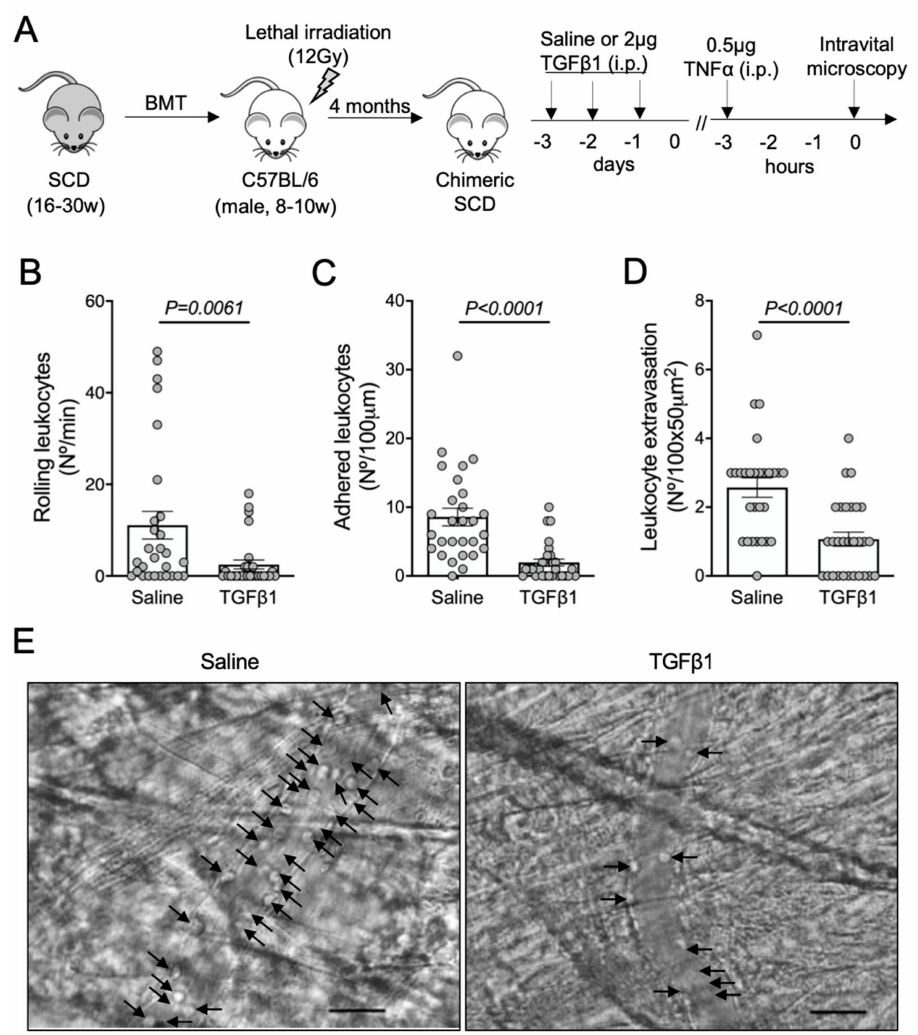
Figure 1. TNF α -induced vaso-occlusion in the microvasculature of SCD mice pre-treated with TGF- β 1: ( A ) experimental design. Chimeric SCD mice were generated by transplantation of bone marrow cells (BMT) from transgenic SCD mice into lethally irradiated (12Gy) C57BL/6 male mice. After complete bone marrow repopulation (4 months), animals received TGF- β 1 (2 µ g, i.p) or saline as control for three consecutive days. On the fourth day, TNF α (0.5 µ g, i.p.) was administered to induce acute vaso-occlusion. The microcirculation of the cremaster muscle was visualized by intravital microscopy; ( B ) number of rolling leukocytes (Nº/100 µ m/min); ( C ) number of leukocytes adhered to endothelium (Nº/100 µ m); ( D ) number of leukocytes extravasated to tissue (Nº/100 × 50 µ m 2 ). Saline group: N = 4 mice, 28 venules. TGF- β 1 group: N = 3 mice, 29 venules. Mann–Whitney test for ( B , C ); Student’s t -test for ( D ); ( E ) representative images obtained during intravital microscopy (left: Video S1; right: Video S2). Arrows indicate leukocytes interacting with the endothelium (e.g., adhered or rolling). Scale bar = 20 µ